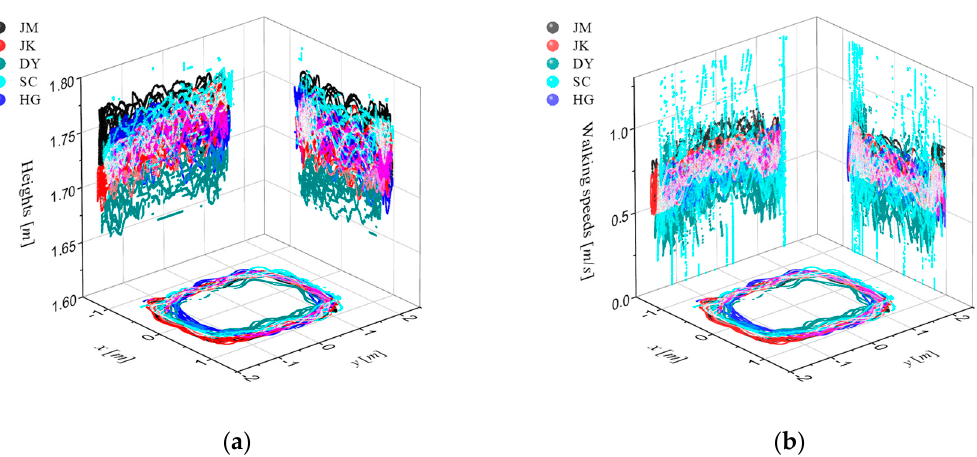
Figure 5. Walking trajectories ( a ) and speeds ( b ) of every subject measured with six OptiTrack Prime 13 cameras.